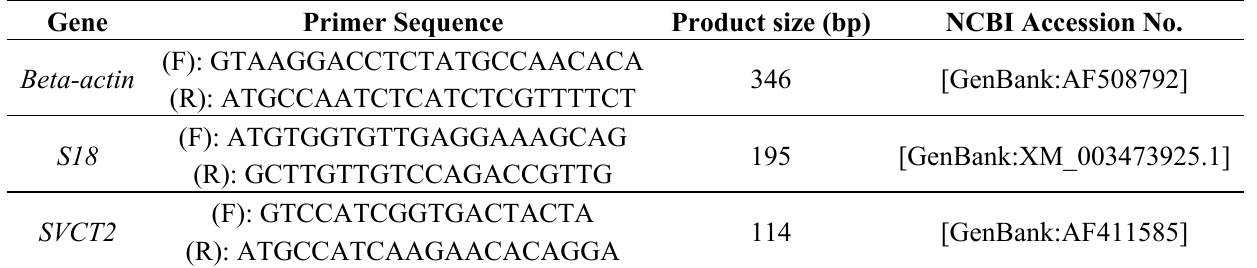
Table 1. Primers for PCR and quantitative PCR